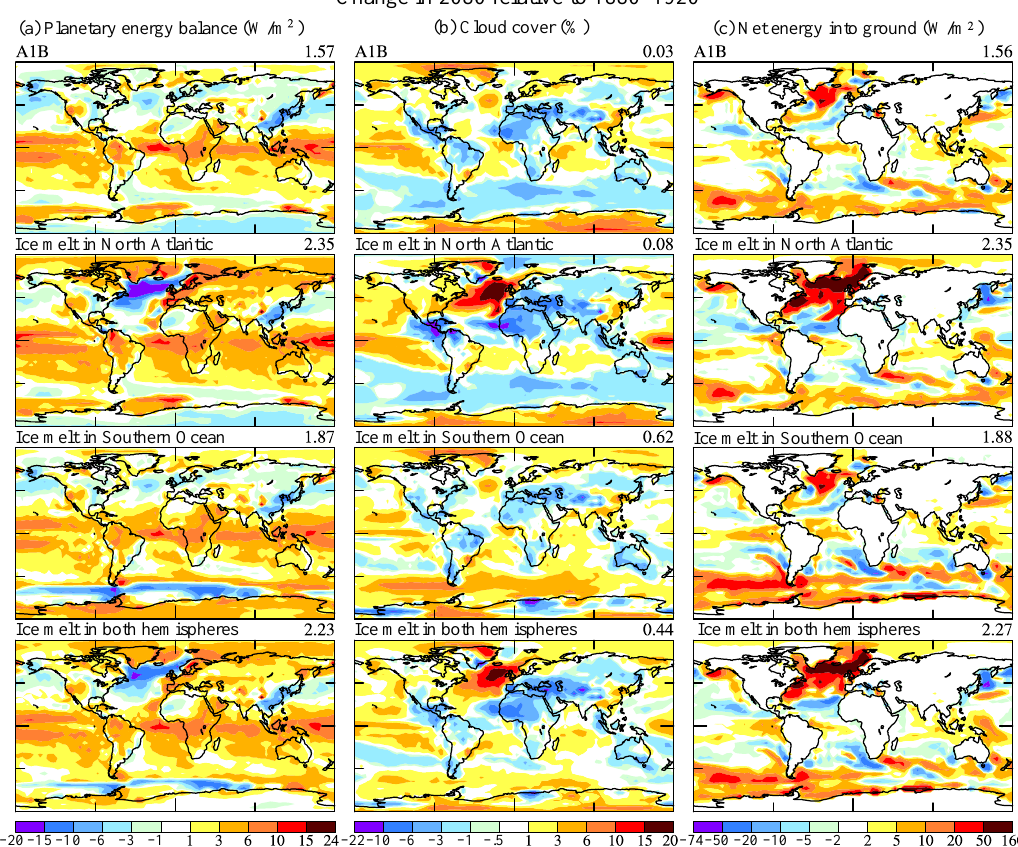
Figure 8. Change in 2080 (mean of 2078–2082), relative to 1880–1920, of annual mean (a) planetary energy balance (Wm − 2 ) , (b) cloud cover (%), and (c) net energy into ground (Wm − 2 ) for the same scenarios as Fig. 6.